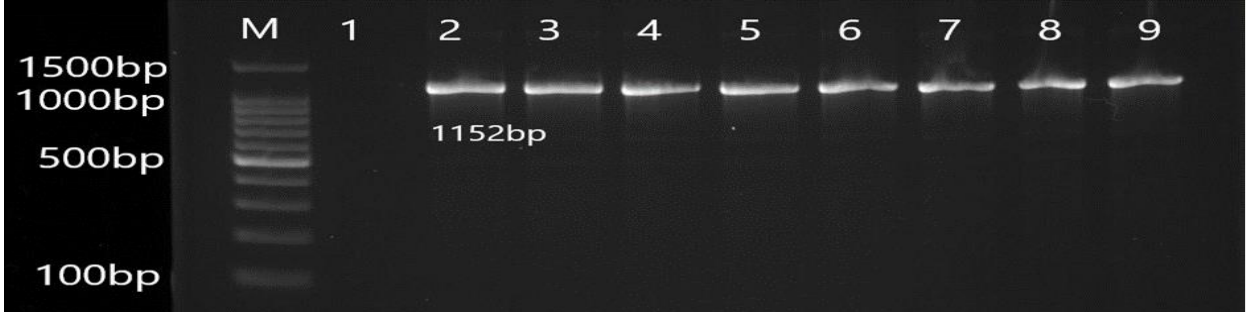
Figure 1. Electrophoresis showing amplicons of P. aeruginosa mexB gene. Lane M: 100 bp plus molecular marker, Lane 1: Negative control, Lane 2–9: Positive isolates of mexB gene.